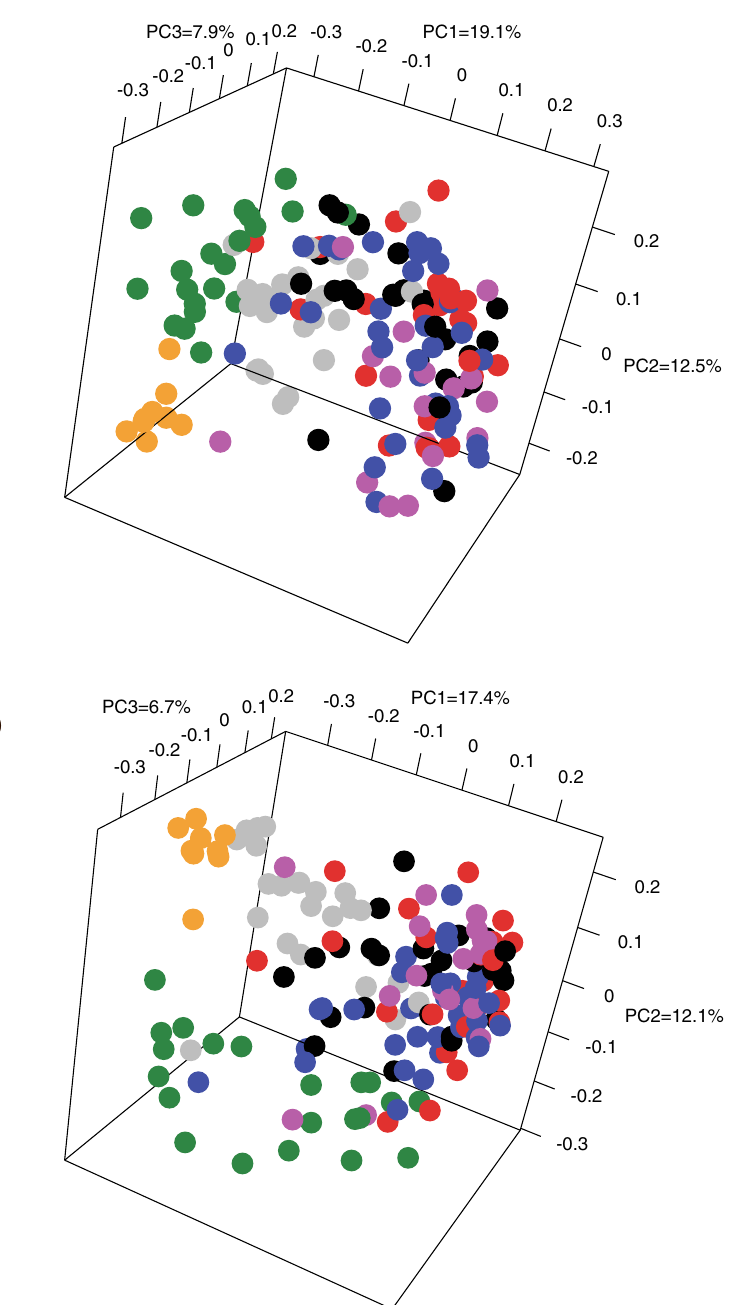
Figure 5. PCoA plots comparing the subgingival plaque bacterial communities from our patients with liver cirrhosis and periodontitis with periodontitis patients and healthy controls from the studies of Hong et al . 37 , Griffen et al . 35 , and Abusleme et al . 36 . The percentage of variation explained by each principal coordinate (PC) is indicated on the axes. Each point represents a microbial community. The plots are based on the OTU structure (ThetaYC calculator) using 98.5% sequence similarity for clustering ( A ) and on Unweighted UniFrac distances from the phylogenetic tree generated from the Clearcut program implemented in the Mothur software ( B ). Samples from our liver cirrhosis patients are shown in green, healthy control samples from the Abusleme study are shown in orange, periodontitis patients from the Abusleme are shown in purple, periodontitis samples from the Hong study are shown blue, periodontitis samples from deep sites from the Griffen study are shown in red, periodontitis samples from shallow sites from the Griffen study are shown in black, and healthy control samples from the Griffen study are shown in